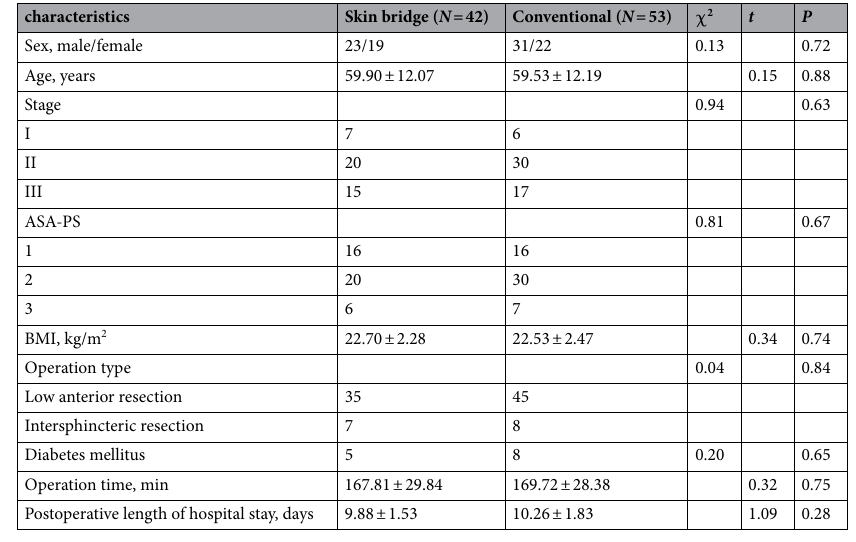
Table 1. Patient